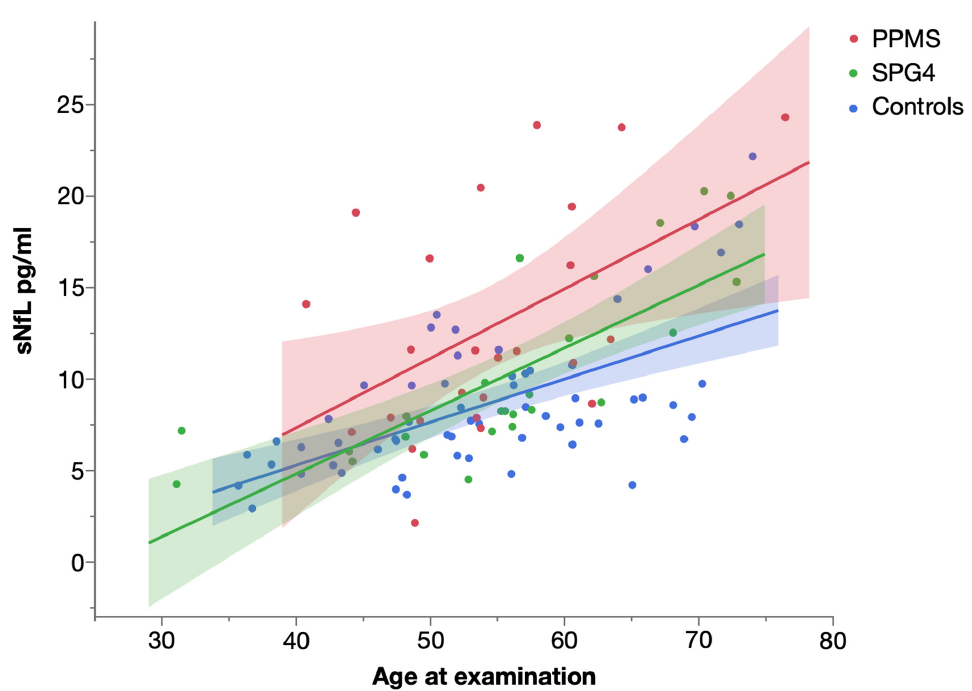
Figure 4. Scatter plot of serum NfL levels in PPMS, SPG4 and controls by age, with linear fit. Shaded areas represent 95% confidence intervals. A statistically significant correlation of sGFAP levels and age (Figure 5) was only seen in SPG4 patients (Spearman’s ρ = 0.554, p = 0.004), whereas it was absent in PPMS (possibly not significant due to the higher variability; Spearman’s ρ = 0.198, p = 0.344) and controls (Spearman’s ρ = 0.213, p = 0.103).